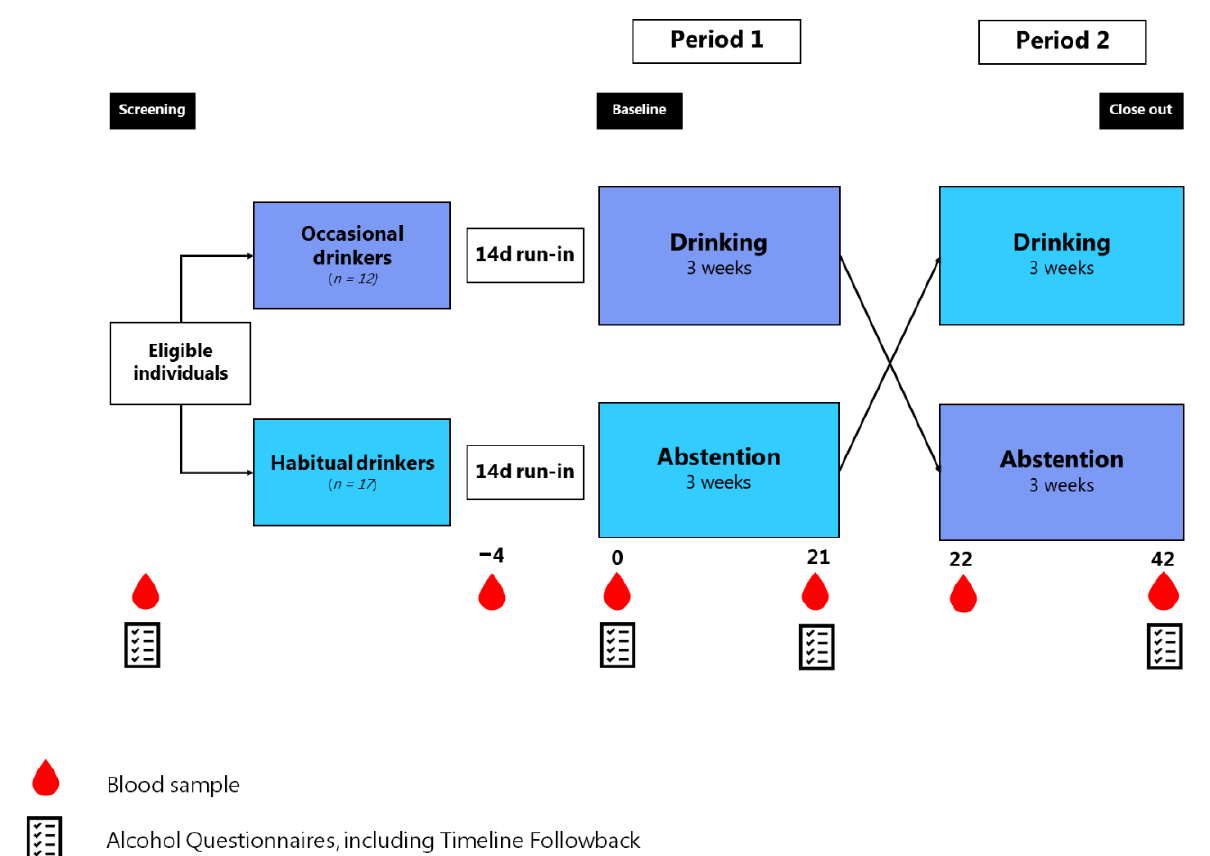
Figure 1. Overview of the MetAl1 study design. Occasional drinkers: habitual